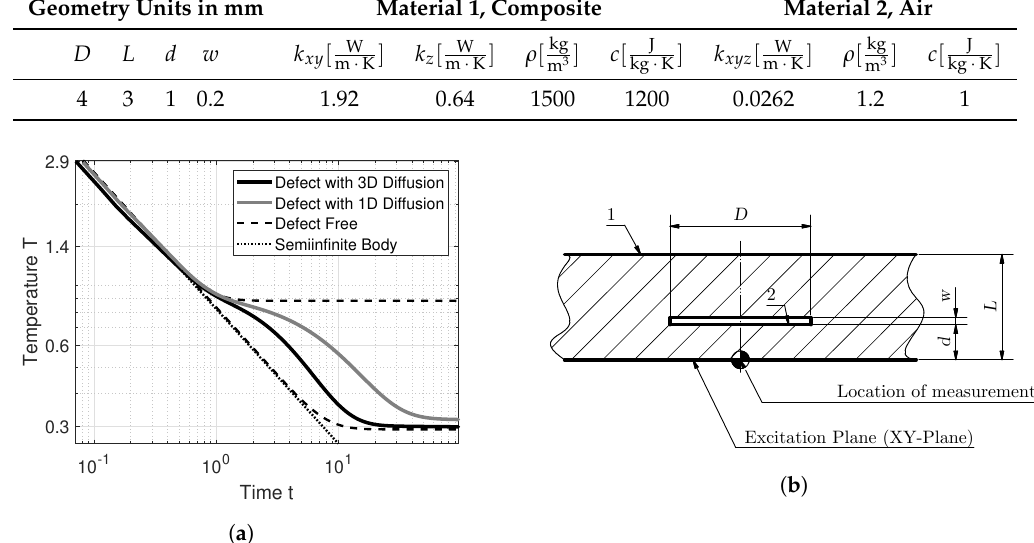
Figure 2. Numerical solution of the heat equation: ( a ) simulated temperature–time sequences and ( b ) the geometry used for the numerical simulations. Figure 2a shows four temperature–time